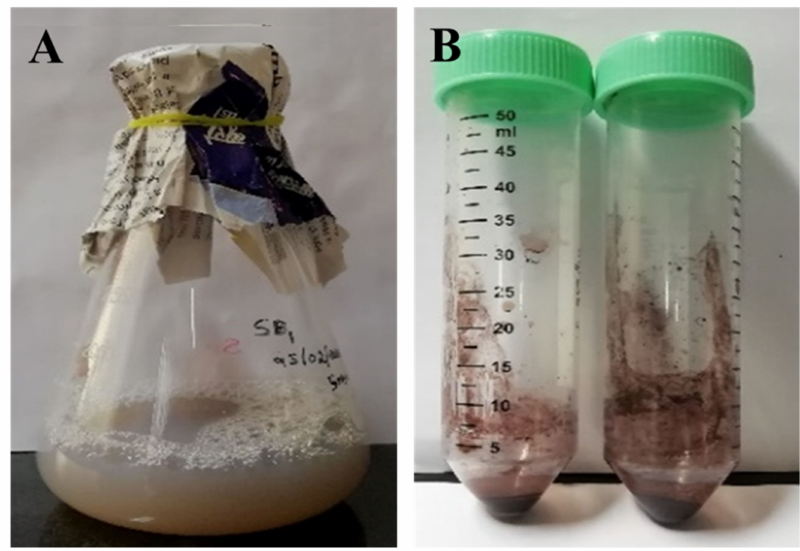
Figure 2. ( A ) Bacterial culture impregnated with metal Ag. ( B ) Green AgNPs (5 mM) are synthesized by endophytic bacteria from the bark of Terminalia arjuna